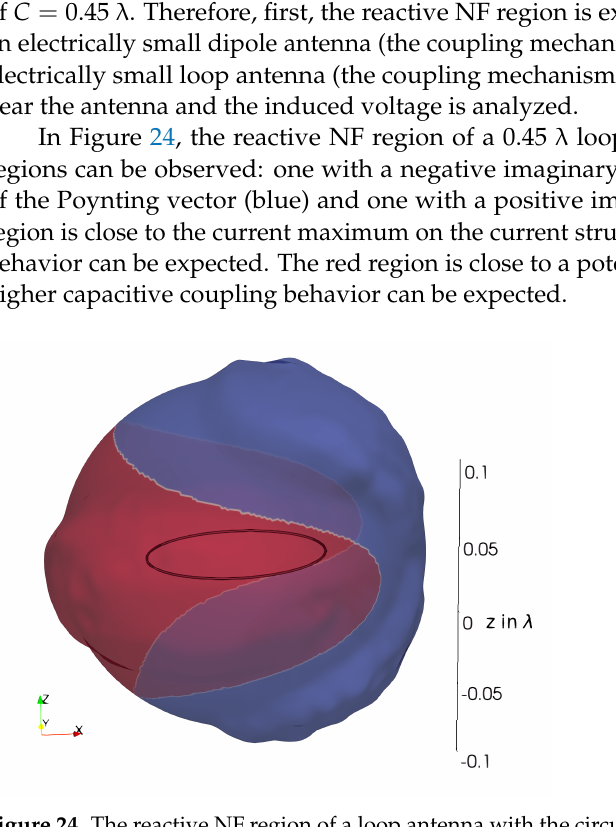
Figure 24. The reactive NF region of a loop antenna with the circumference of C = 0.45 λ , determined by applying the error-estimator in 11, is given. The red surface shows the region where the imaginary part of the normal component of the Poynting vector is positive, and the blue surface shows the region with a negative imaginary